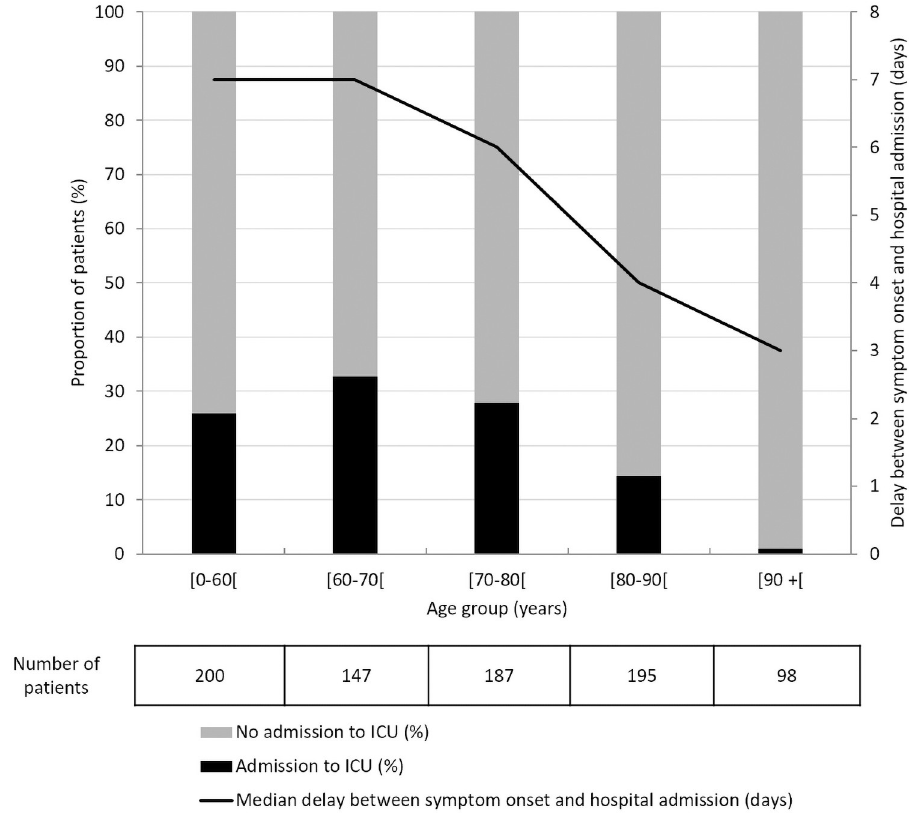
Fig 1. Delays between symptom onset and hospital admission and proportions of admission to ICU according to patient age, Lyon University Hospital (NOSO-COR Study), February 8–June 30, 2020. Note: Admission to ICU includes patients directly admitted to ICU and patients hospitalized in a medical ward and subsequently transferred to ICU during their hospitalization.